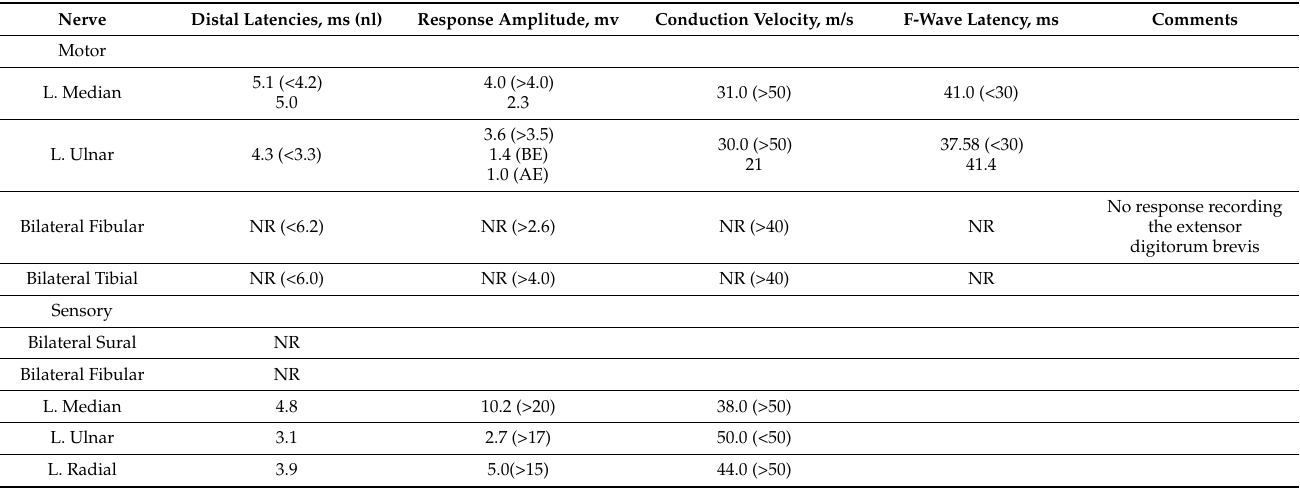
Table 1. Nerve conduction studies in the index